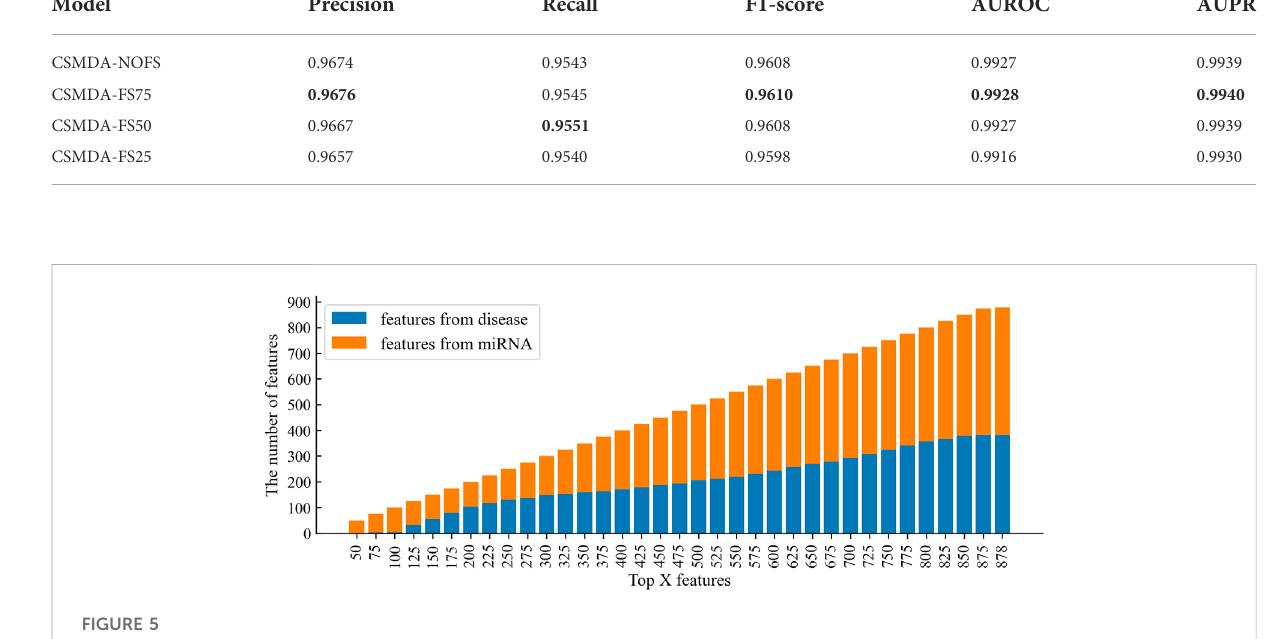
TABLE 2 Performance comparison of the CSMDA under different dimension training samples. Model